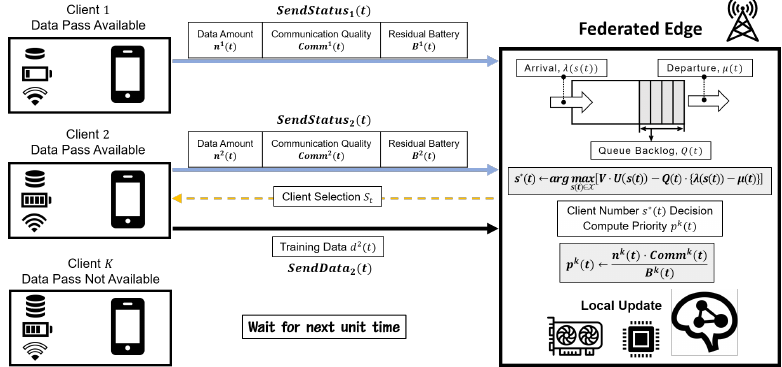
Figure 6. The federated edge selects the number of clients to receive the data from and selects these clients from amongst those available, according to each client’s resource